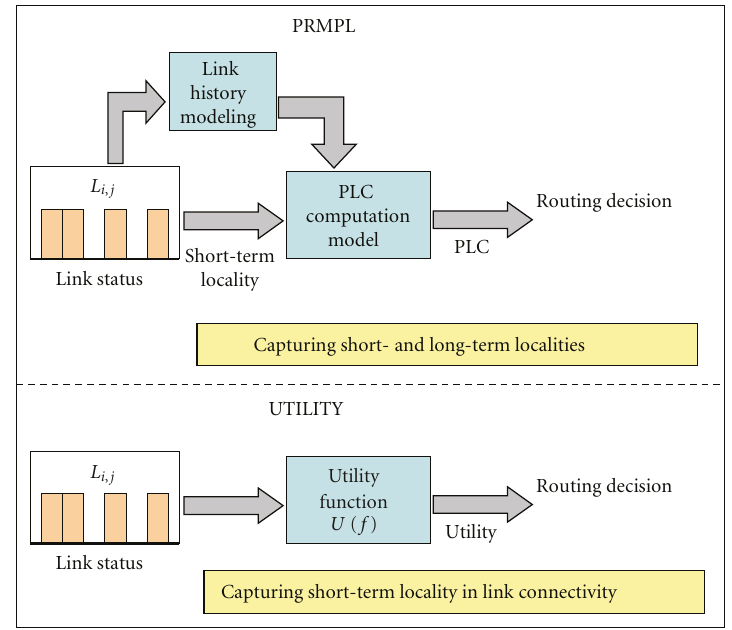
Figure 8: Capturing link connectivity locality in PRMPL and UTILITY age-based